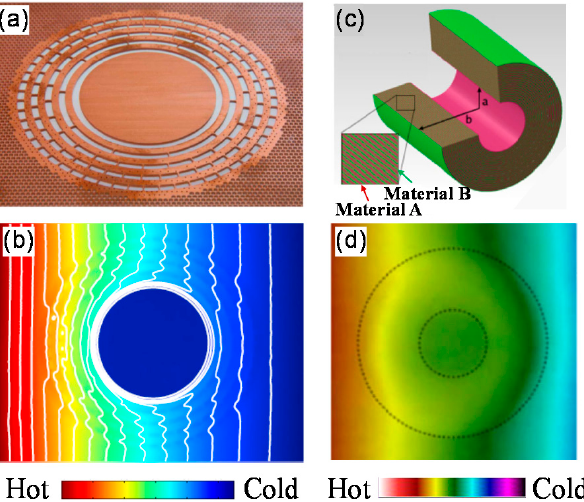
Figure 2. Demonstration of TO-based thermal cloak and multilayered thermal cloak. ( a ) TO-based thermal cloak [19]. ( b ) Measured temperature distribution of ( a ). ( c ) Multilayered thermal cloak [29]. ( d ) Measured temperature distribution of ( c